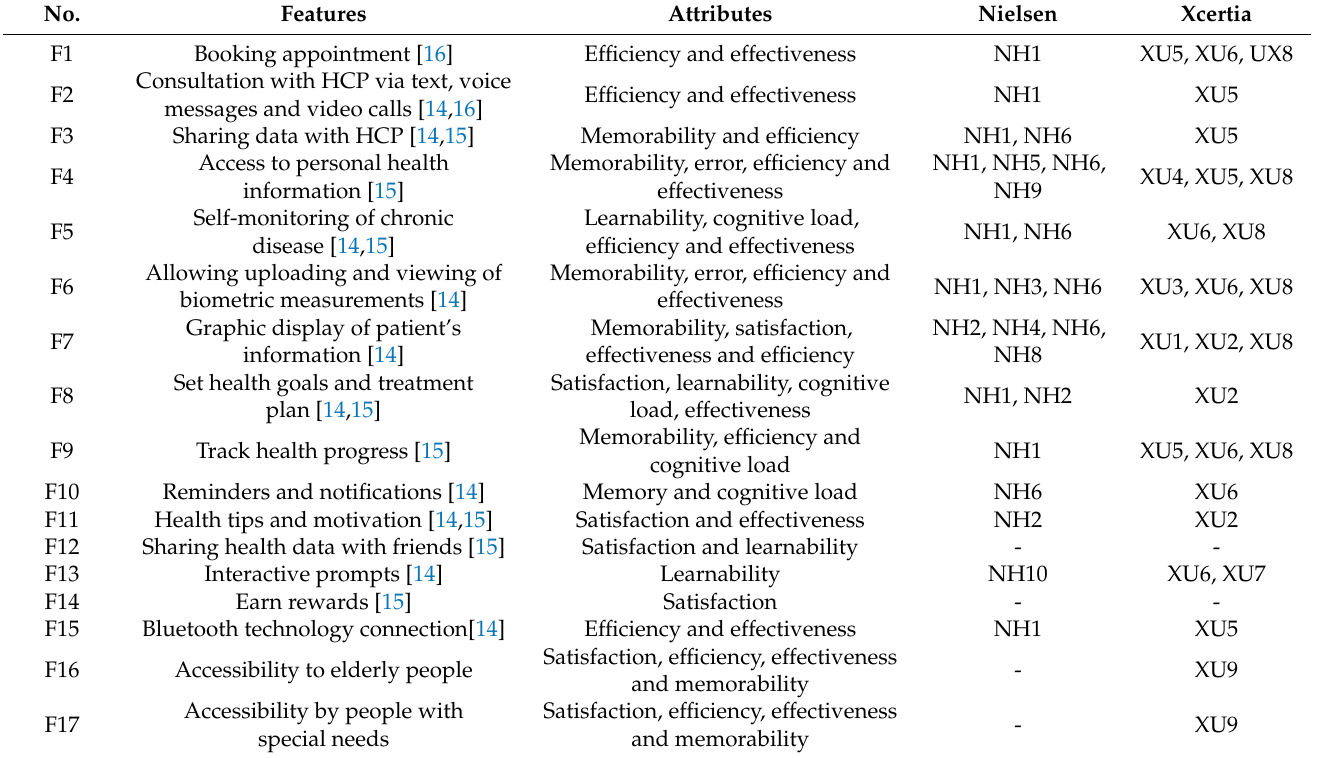
Table 3. Matching among features, attributes and